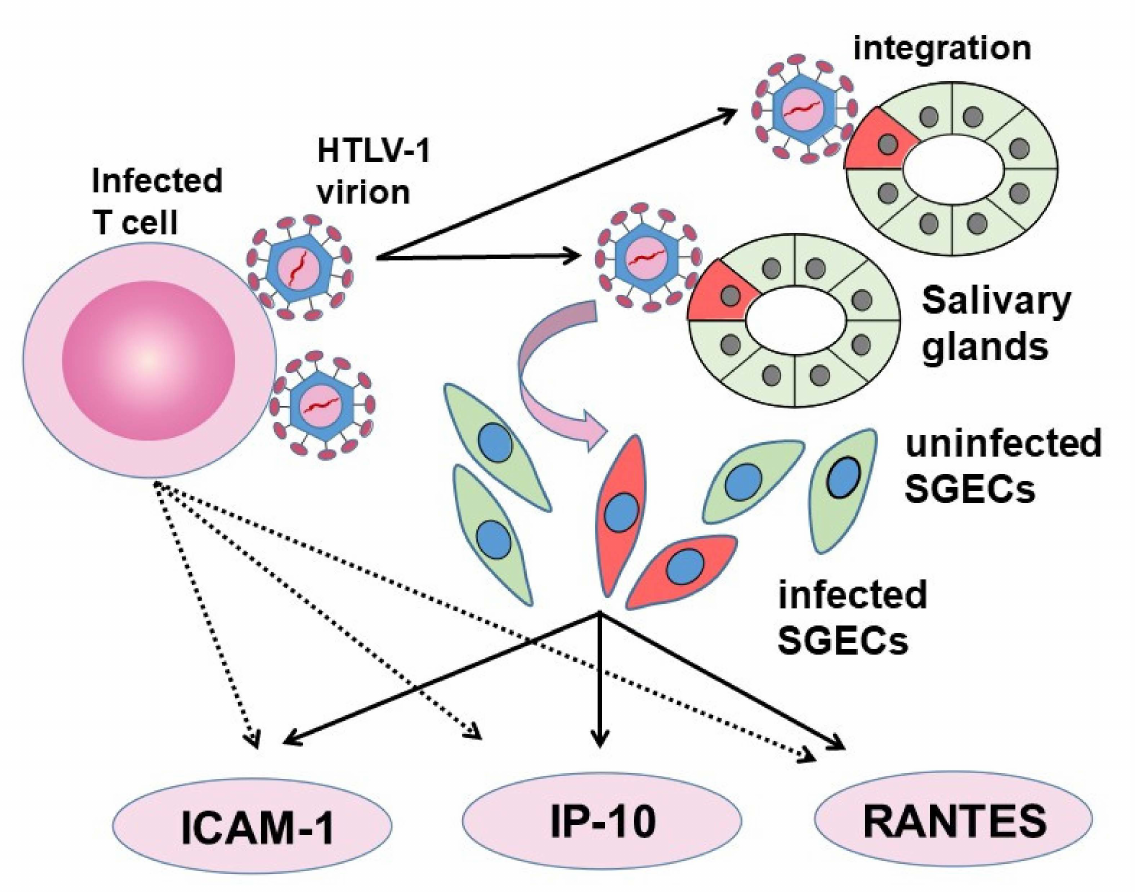
Figure 3. Involvement of HTLV-1 infected SGECs in SS. Virus particles are exposed on the surface of HTLV-1-.infected cell lines, and these infected cell lines produce molecules involved in adhesion, inflammation, and migration, such as ICAM-1, IP-10, and RANTES. HTLV-1 particles migrate to the salivary glands via cell-to-cell contact with infected cells and HTLV-1 DNA becomes integrated into some SGECs. The infected SGECs themselves also have the ability to produce ICAM-1, IP-10, and RANTES, and can be involved in chronic